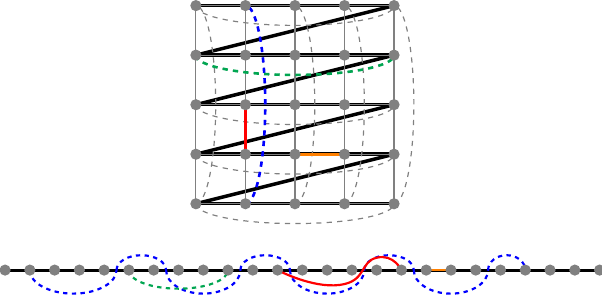
FIG. 2. A nonplanar graph G (shown with gray edges) and # G (shown with solid black edges). The edges along the “ seams ” of the torus are shown as dashed lines. As in the planar case of Fig. 1, we also show the deformation of several edges into linearized braid